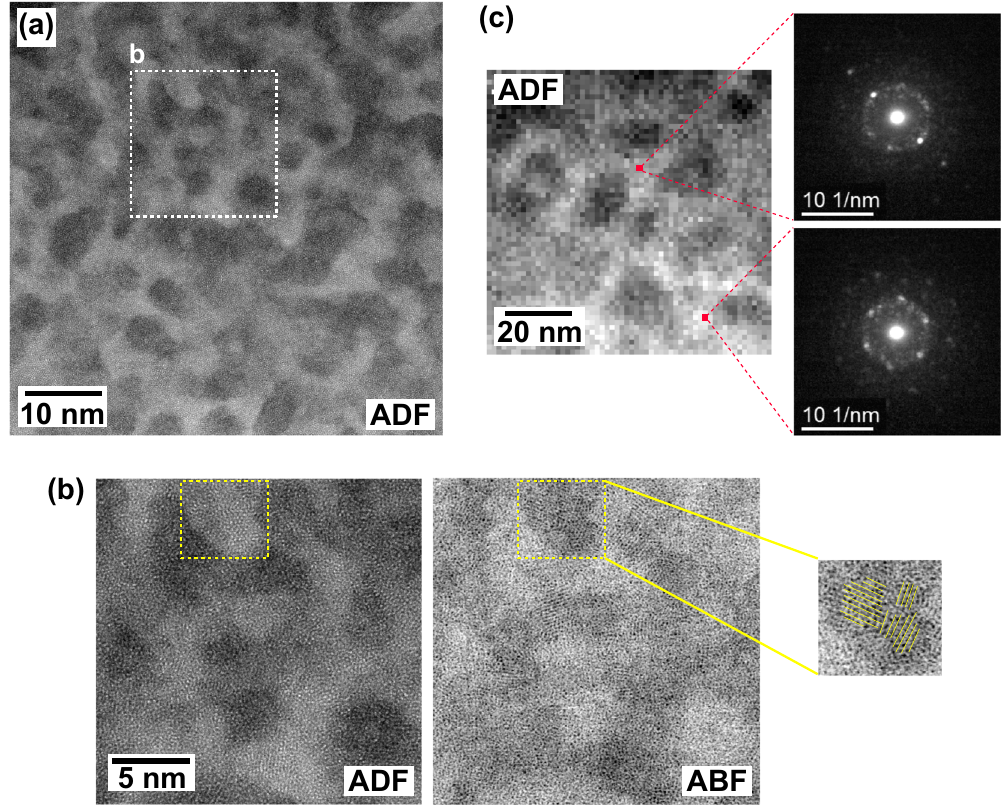
Fig. 6 ADF-STEM images of the pHPQ Zr 50 Cu 40 Al 10 sample synthesized at 5.5 GPa and 880 K. a ADF-STEM image of the sample. b High-magni fi cation version of image in a . Left and right images are the ADF-STEM, and ABF-STEM images, respectively. Yellow dotted square shows typical Cu-rich ordered region. Yellow lines are traces of fringe-like contrast in the yellow dotted square. c Nanobeam electron diffraction patterns in the bright area in the ADF- STEM image. Area is different from that of a in the same pHPQ